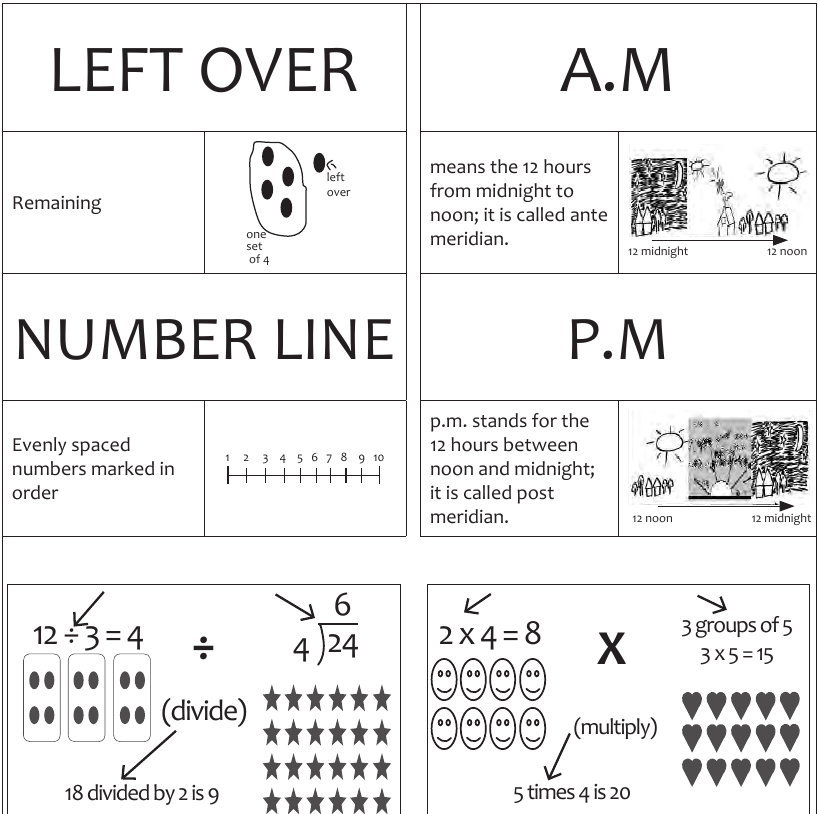
Figure 1 : Word Walls (Education Quality and Accountability Office,